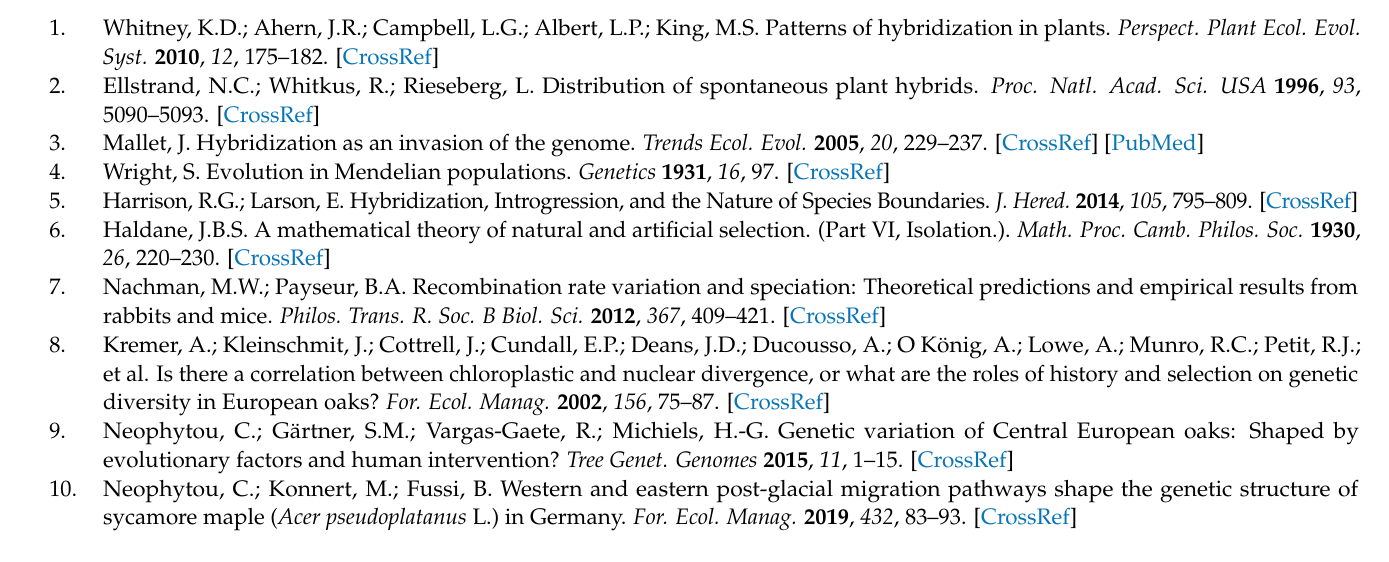
Table S2: Search ranges of parameters in ABC model; Table S3: Genetic diversity of each sampled population and species; Table S4: Pairwise F ST between populations of two maple species; Table S5: Model comparison between four scenarios with the Bayes factor; Table S6: Estimates of model parameters for the four scenarios through approximate Bayesian